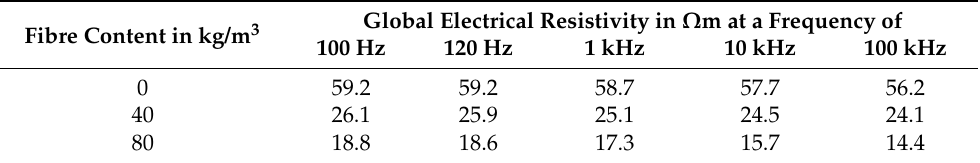
Table A45. Results of the resistivity measurements of the concrete mixture 32-60-300-00 after storage in Ca(OH) 2 for 91 days for the investigations of possible leaching effects.